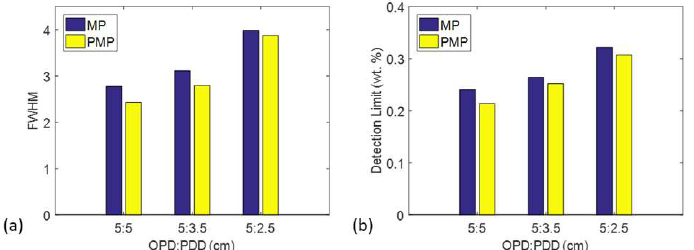
Figure 6. ( a ) FWHM and ( b ) detection limit for PMP and MP geometries for different OPD and PDD values. Results are shown for the nine pinholes.